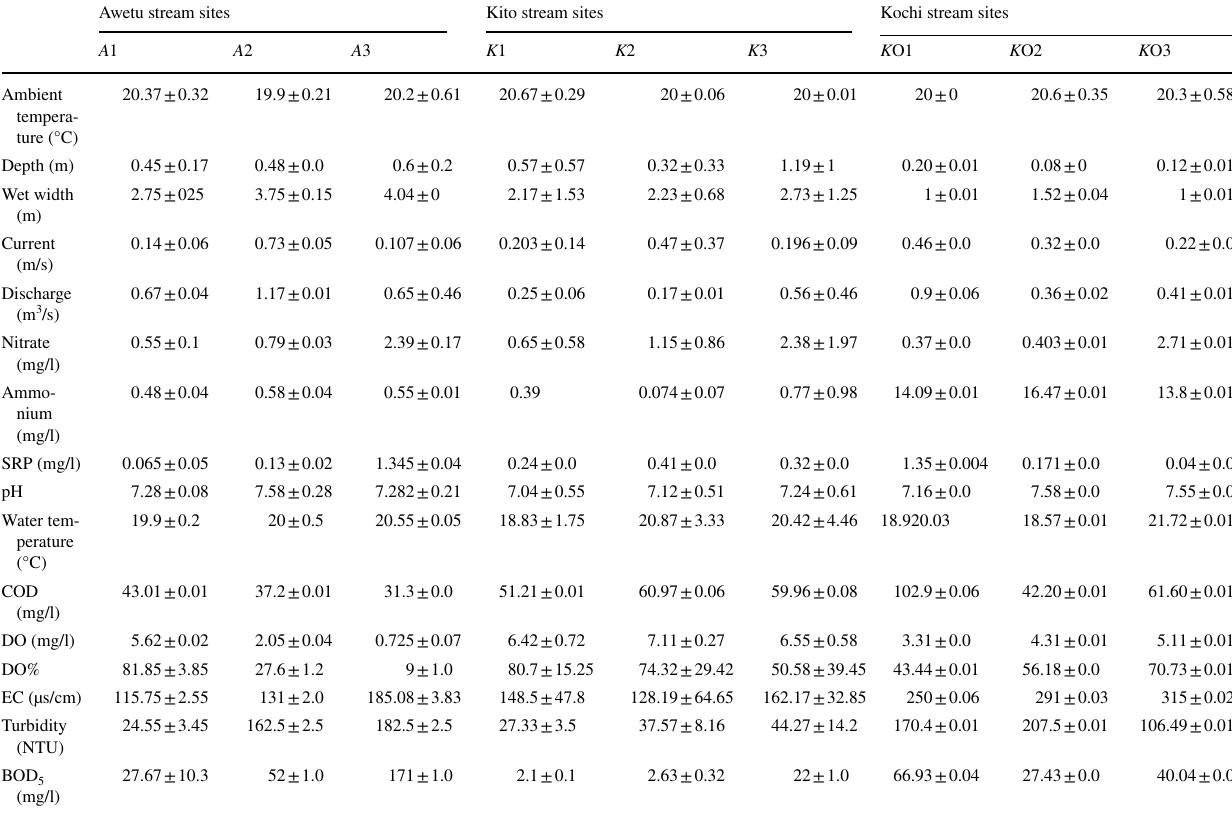
Table 2 Mean (± SE) values for measured physicochemical characteristics of nine study sites in urban catchment Awetu stream sites